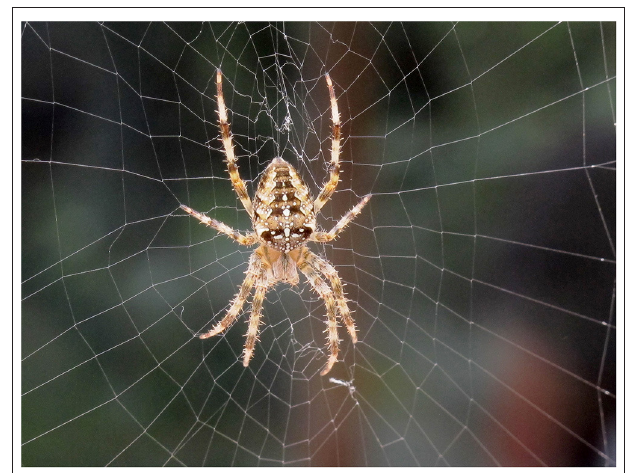
FIGURE 1 | Orb-weaver spider in London garden,